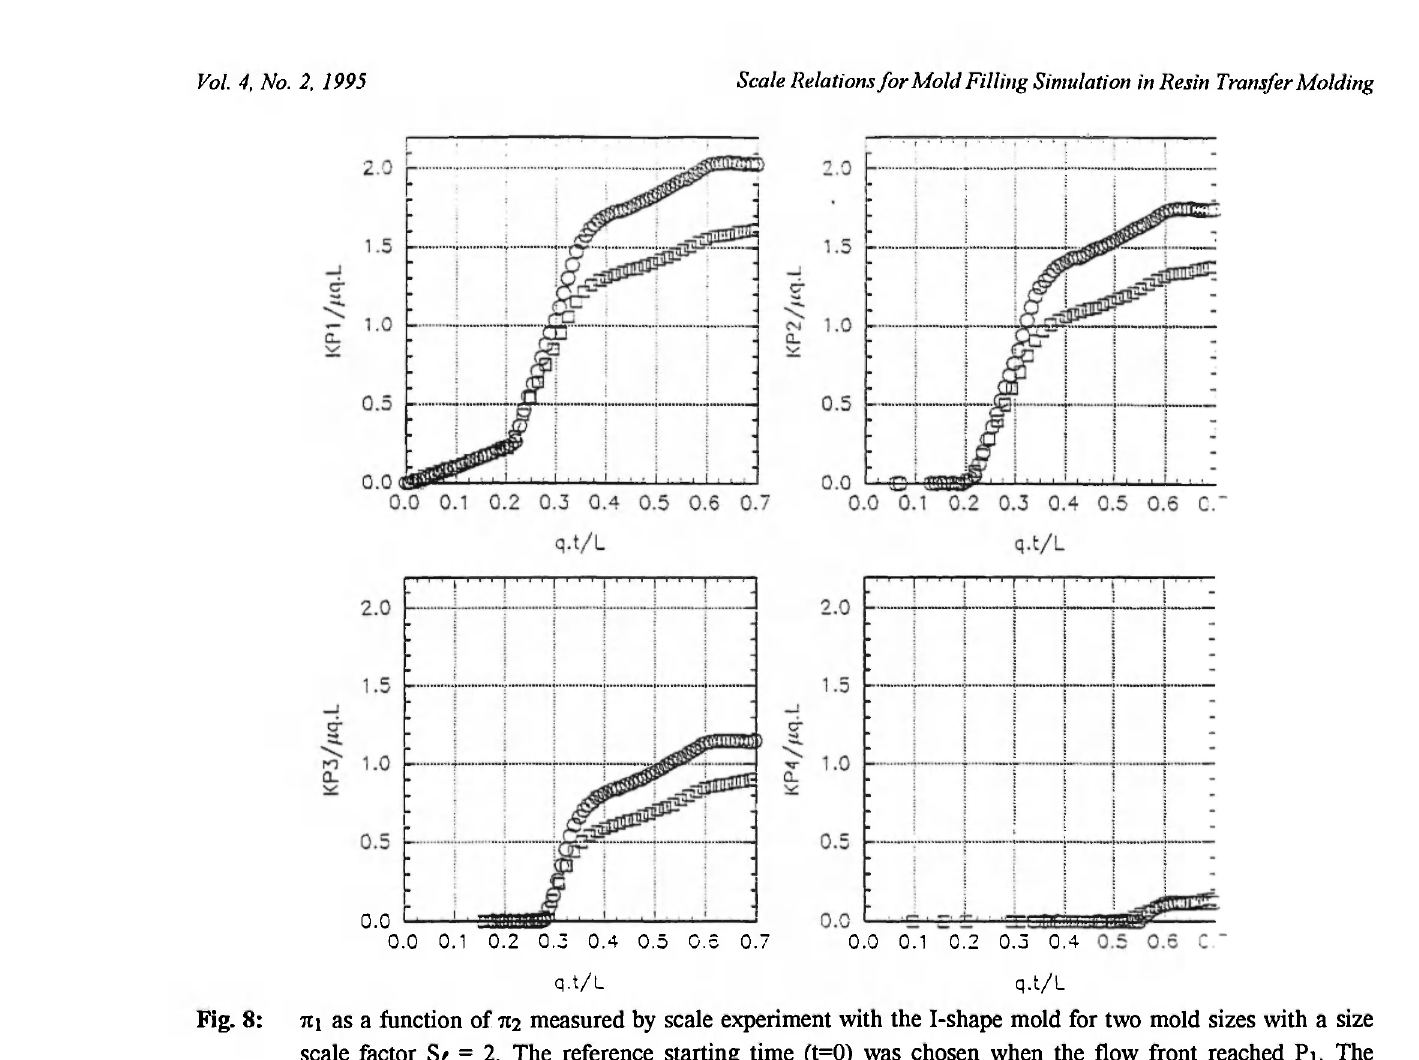
0.0 0.0 0.1 0.2 0.2 0.4 0.5 0.5 0.7 0.4 q.t/L q.t/L Fig. 8: πι as a function of it2 measured by scale experiment with the I-shape mold for two mold sizes with a size scale factor S/ = 2. The reference starting time (t=0) was chosen when the flow front reached Pi. The pressure was measured at point (a) Pi; (b) P2; P3 (d) P4, (•) for the large mold and (O) for the small